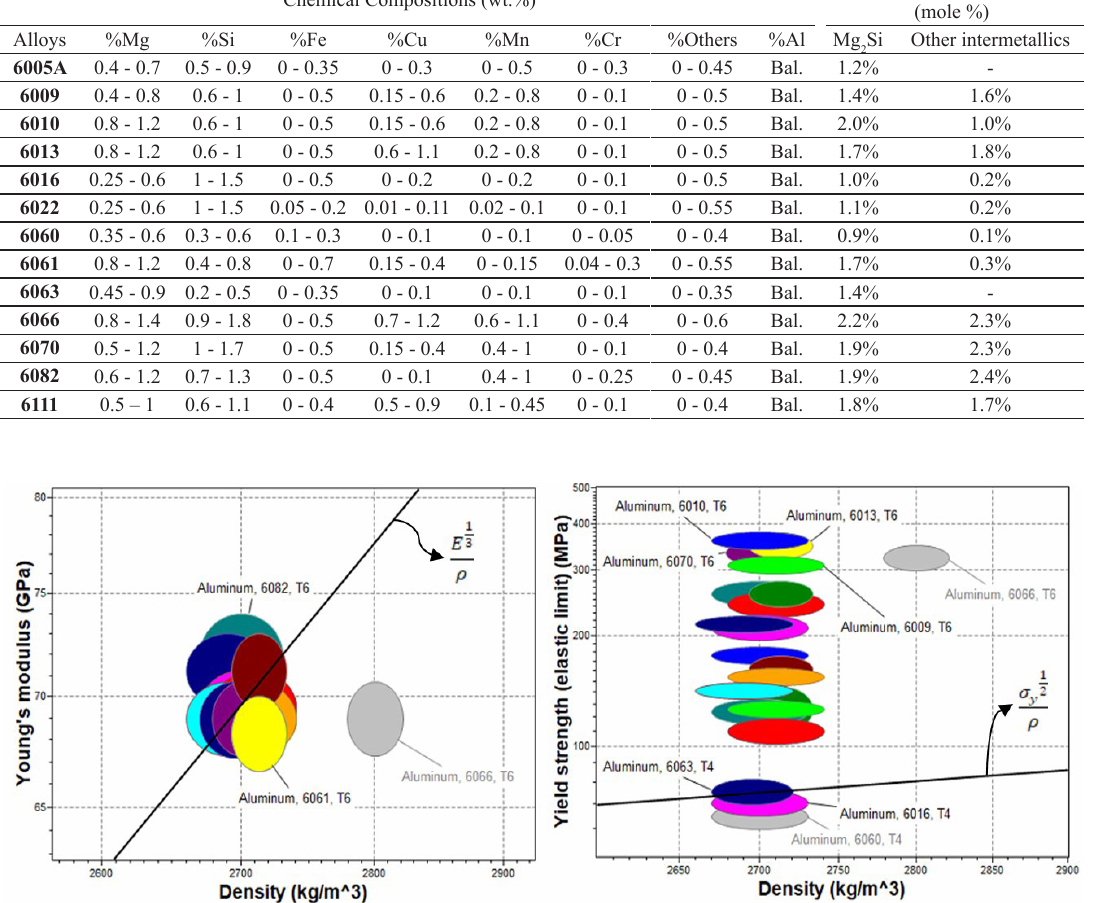
Table 1. Compositions and phase fractions characterizing the 6000 alloys examined in this study. Chemical Compositions (wt.%)